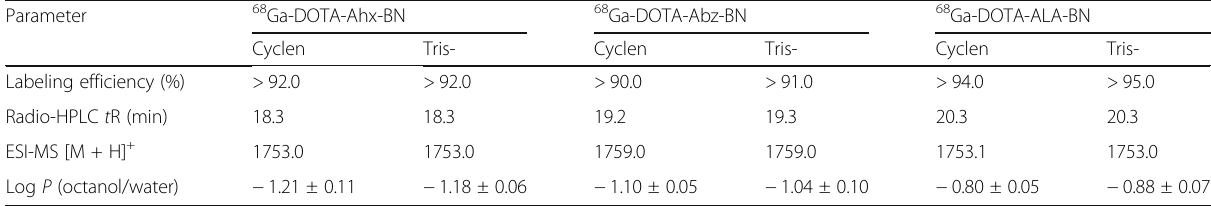
Table 1 Characteristics of the 68 Ga-labeled BN peptides